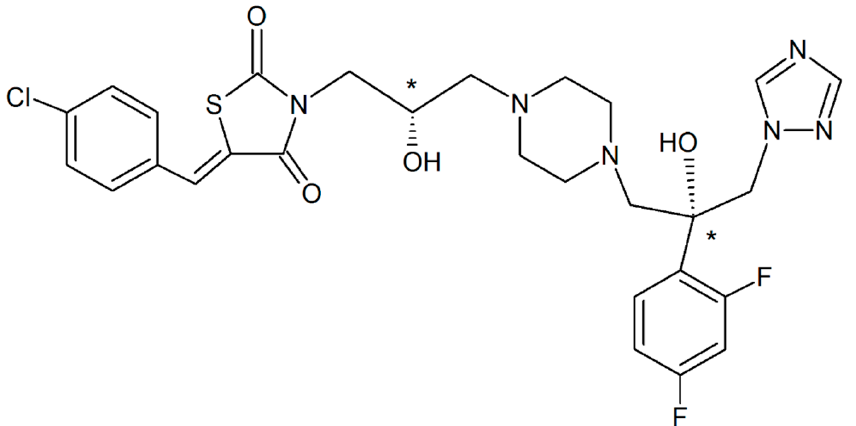
Figure 1. Structure of the studied compounds. Chiral centers are marked by